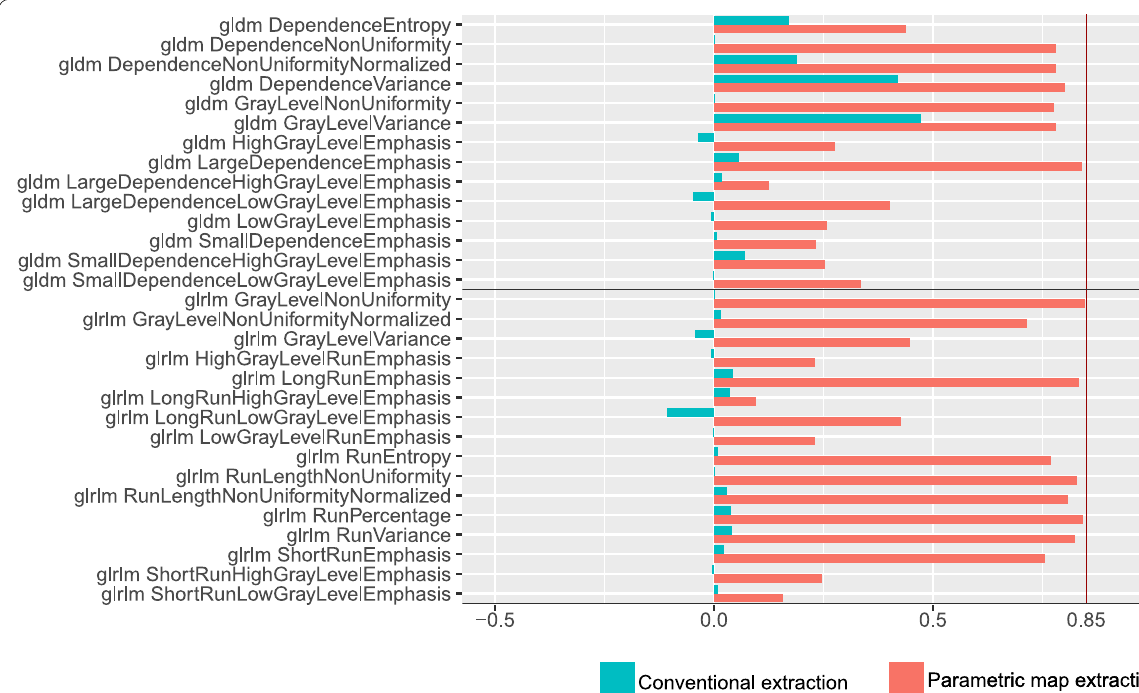
Fig. 4 OCCC 8,16 of higher‑order features: conventional and parametric map extraction. Barplots of GLDM and GLRLM features are shown. The green bars illustrate the OCCC 8,16 values of the conventional feature extraction. The red bars depict the OCCC 8,16 values when extracted from the parametric maps. The red line at 0.85 indicates excellent agreement. The OCCCs from parametric maps show a substantial increase in stability across the 8 and 16 mm VOI diameters (Supplementary Fig. S8 contains barplots of the OCCC 4–16 values of all features and Fig. S9 of the OCCC 8,16 values of all features). OCCC , Overall concordance correlation coefficient;